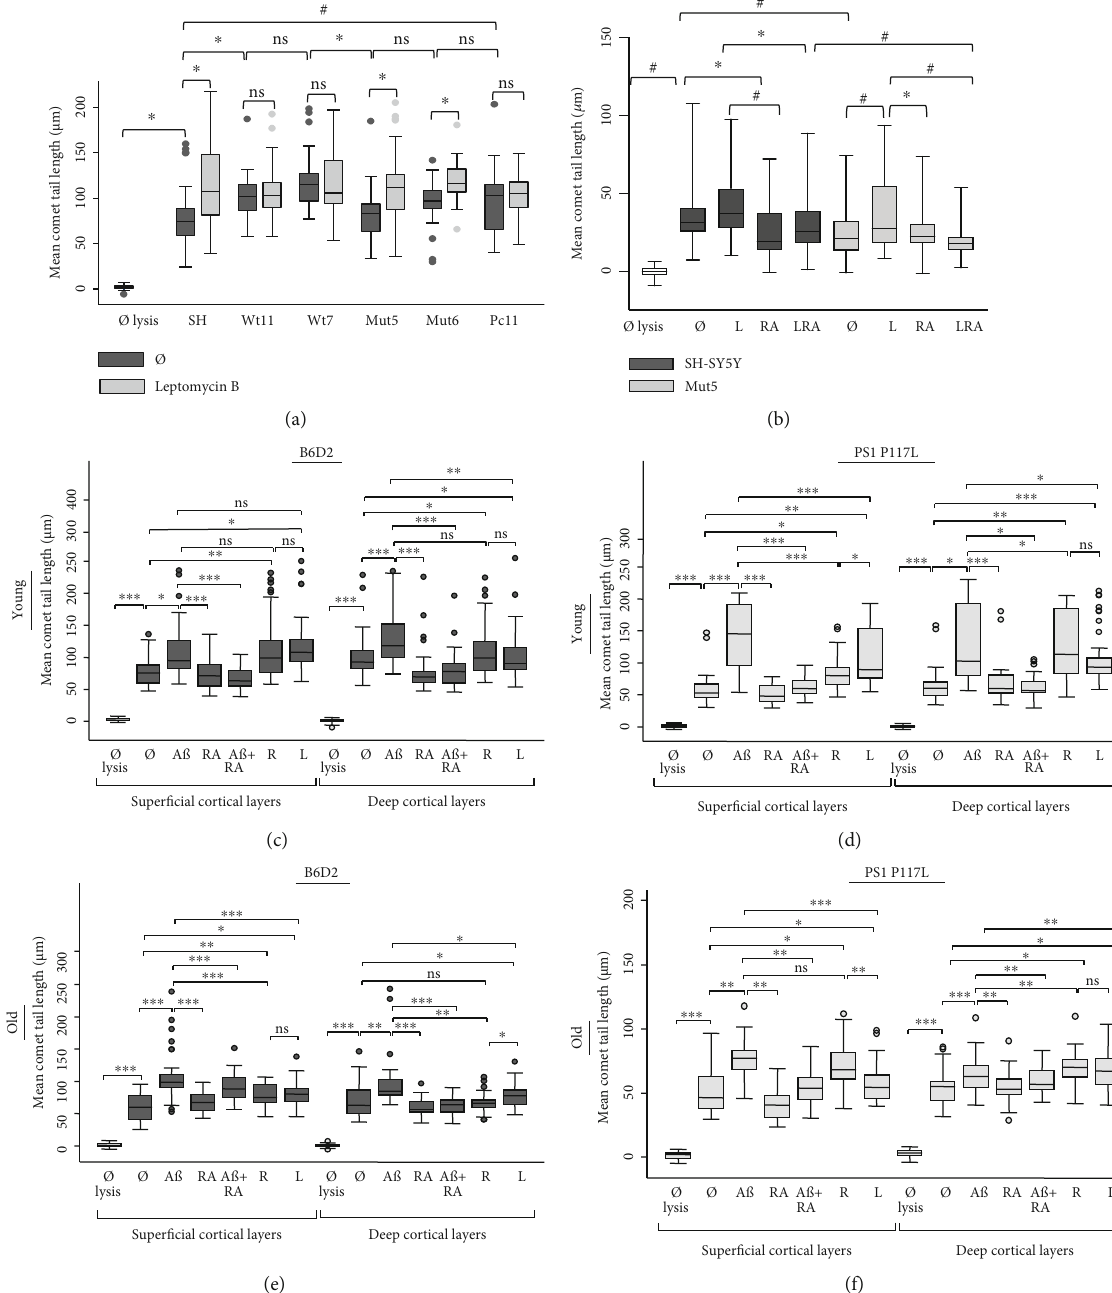
Figure 4: In (a), the SH-SY5Y (SH) cells, the wild-type (Wt) clones, and the mutated (Mut) clones were treated for 30min with 100 nM leptomycin B (L) or not. The treatment increased the comet tail length (in μ M), particularly in the Mut clones (and the SH cells) compared to the Wt clones or the control Pc11 clone (number of cells measured: 33 < n < 46 ). In (b), compared to the untreated cells, leptomycin B (100nM, 30 min) was shown to increase the comet tail length in the Mut5 cells. The all-trans retinoic acid (RA) was shown to decrease DSBs in the SH cells. RA was shown to signi fi cantly decrease DSBs in the presence of leptomycin B (LRA) compared to the leptomycin B treatment, especially in the Mut5 cells (number of cells measured: 90 < n < 97 ). In (a) and (b), ANOVA with Bonferroni multiple comparisons test: ∗ p < 0 : 05 ; # p < 0 : 001 ; ns: nonsigni fi cant (Kruskal-Wallis). (c – f) DSBs in the super fi cial and deep cortical layers of 5-6-month (c and d) or 18-month (e and f) B6D2 (c and e) and PS1 P117L (d and f) female mice ( n = 3 per group c, d, e, or f). The cortical layers were dissected and treated or not with 20 μ M A β , 5 μ M all-trans retinoic acid (RA), A β +RA, 20 μ M roscovitin (R), and 100nM leptomycin B (L) for 30 min. We observed that the increased numbers of DSBs by A β was usually signi fi cantly decreased by the presence of RA. An e ff ect of the strains could also be shown. Comet tails were longer in the PS1 P117L mice treated with roscovitin or leptomycin B compared to the B6D2 mice, for the deep cortical layers and the young mice only. ns: nonsigni fi cant; ∗ p < 0 : 05 for 1 mouse; ∗∗ p < 0 : 05 for 2 mice; ∗∗∗ p < 0 : 05 for 3